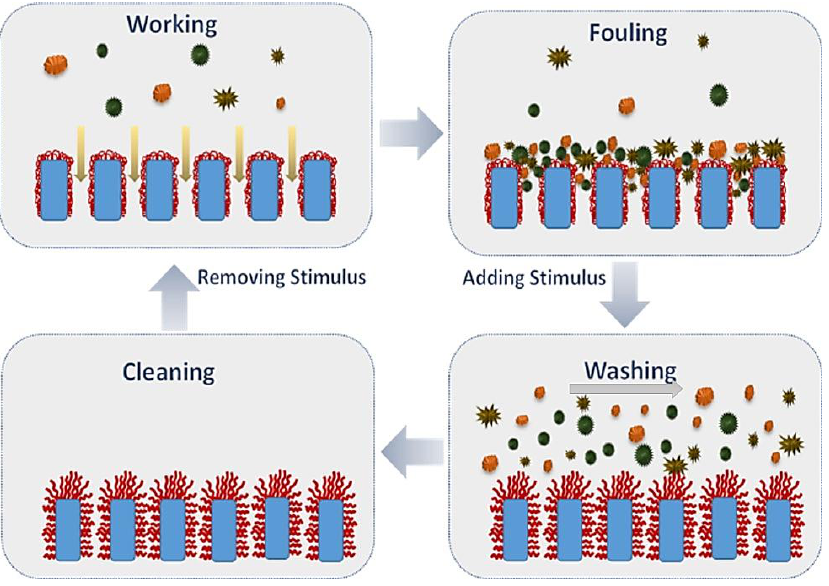
Figure 1. Examples of Stimuli Responsive Membranes. Reprinted from [83], with permission from Royal Society of Chemistry.